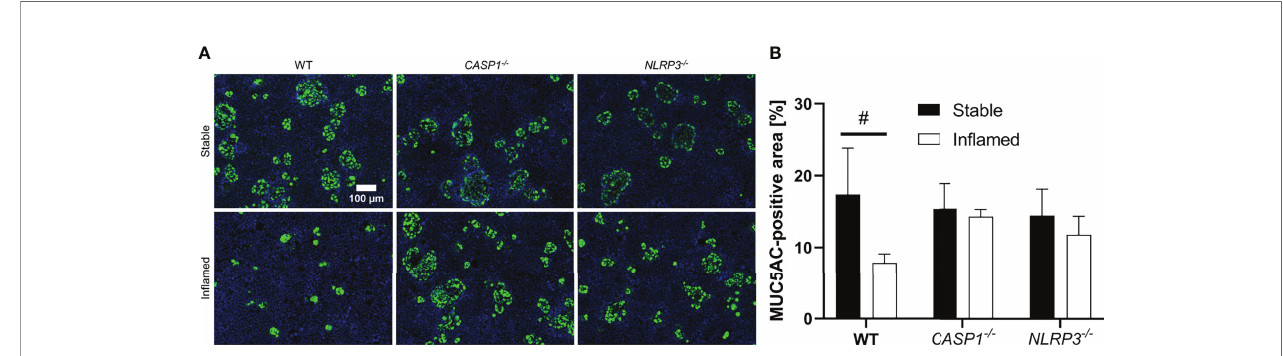
FIGURE 6 | (A) Representative images of MUC5AC-stained epithelial layers of stable (top row) and in fl amed (bottom row) triple cultures with WT, CASP1 -/- or NLRP3 -/- THP-1 cells. Blue: nuclei (Hoechst 33342), green: MUC5AC (Alexa Fluor 488). Images were acquired at 100x magni fi cation. Scale bar (100 μm) applies to all images. (B) Quantitative analysis of MUC5AC-stained area in stable (full bars) or in fl amed (open bars) triple cultures. Mean ± SD of N = 3, # p < 0.05 compared to the respective stable culture.